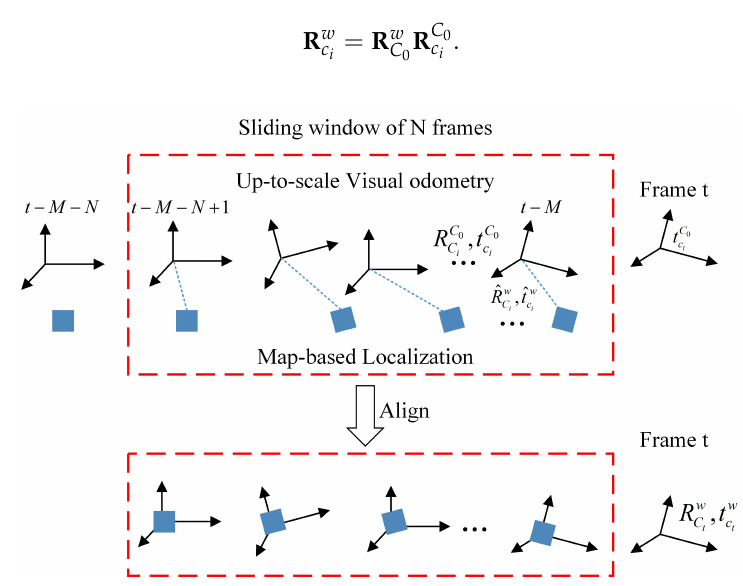
Figure 5. The frame-to-frame motion and map-based localization